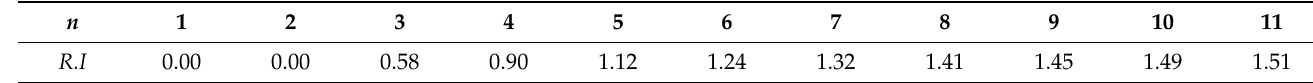
Table 4. Saaty’s ratio index ( R.I ) for different values of ( n ) [14].